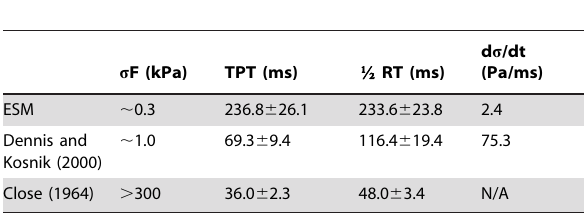
Table 1. Average values for stress, TPT, and K R t from embryonic skeletal muscle (ESM), and previously published work from Dennis and